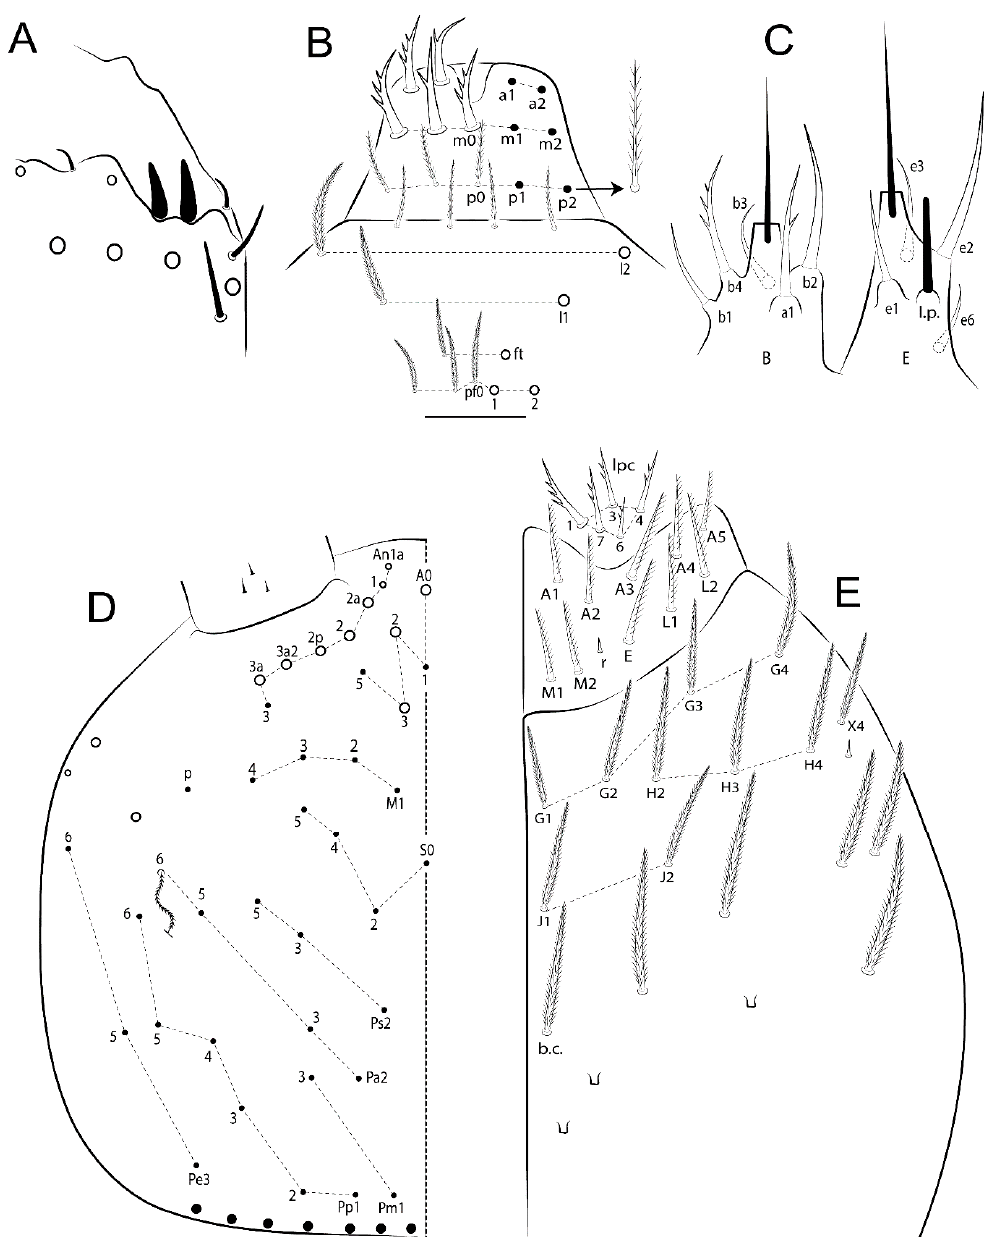
Figure 22. Pseudosinella labruspinata sp. nov.: head. ( A ) Ant III apical organ (lateral view); ( B ) chaetotaxy of clypeus, prelabrum, and labrum; ( C ) labial papillae B and E (right side); ( D ) head dorsal chaetotaxy (left side); ( E ) labial proximal chaetae, basomedian and basolateral labial fields, and complete postlabial chaetotaxy (right side).